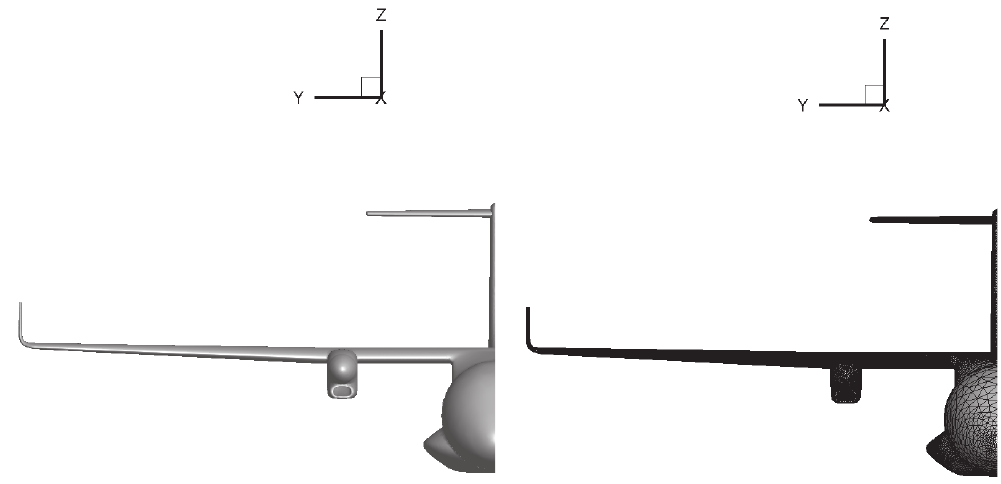
Figure 2. Clean configuration: frontal view of geometric model ( left ) and surface mesh ( right ) for half the domain.